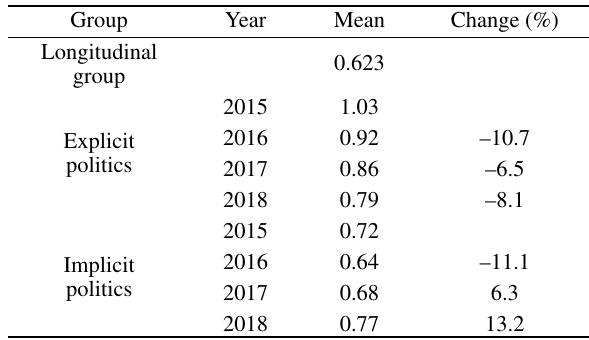
Table 3 Botometer results: Mean